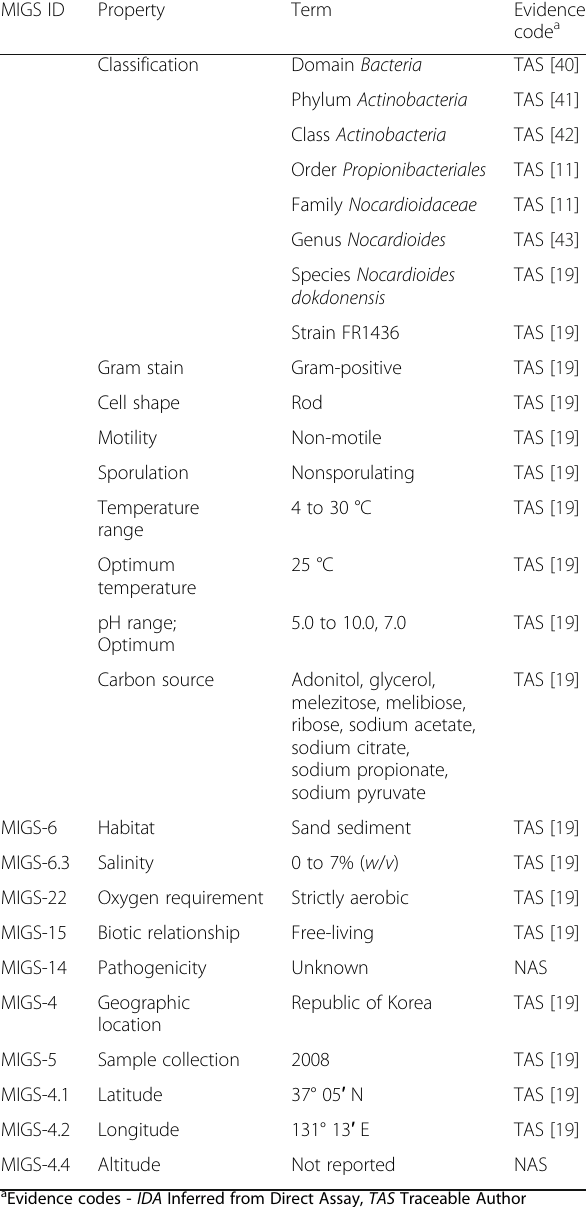
Table 1 Classification and general features of N. dokdonensis FR1436 according to the MIGS recommendations [39]